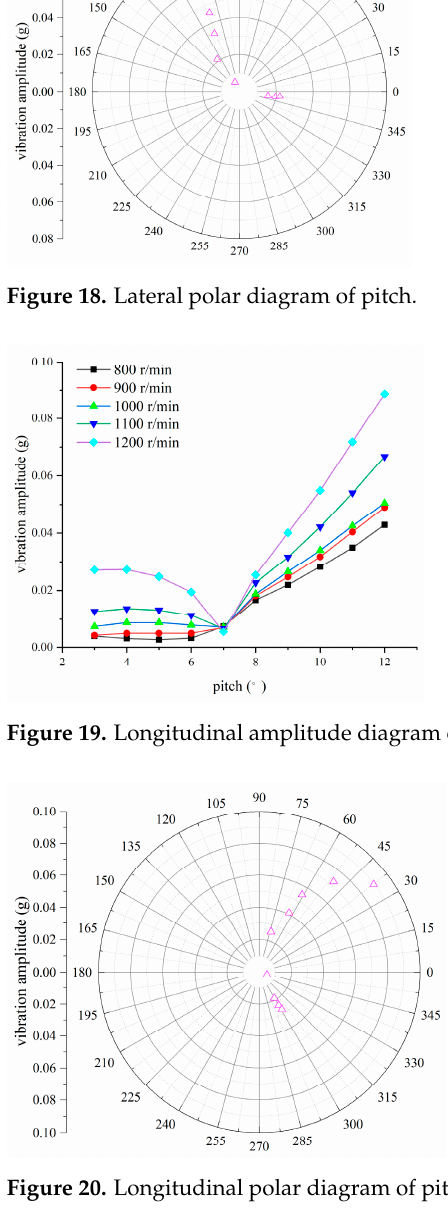
Figure 20. Longitudinal polar diagram of pitch.